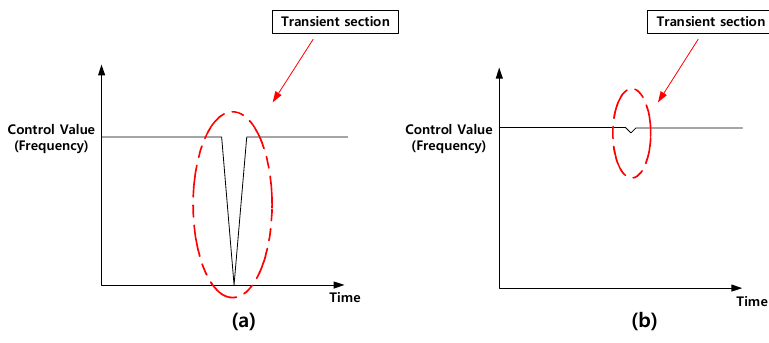
Figure 6. The algorithm application (before ( a ) and after( b )).